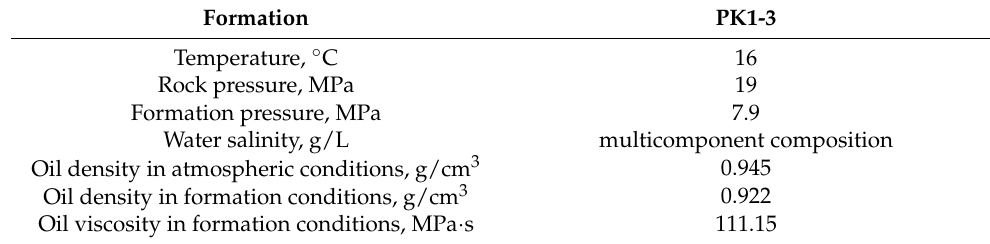
Table 3. Geological and physical characteristics of PK1-3 reservoir of the East-Messoyakhskoe